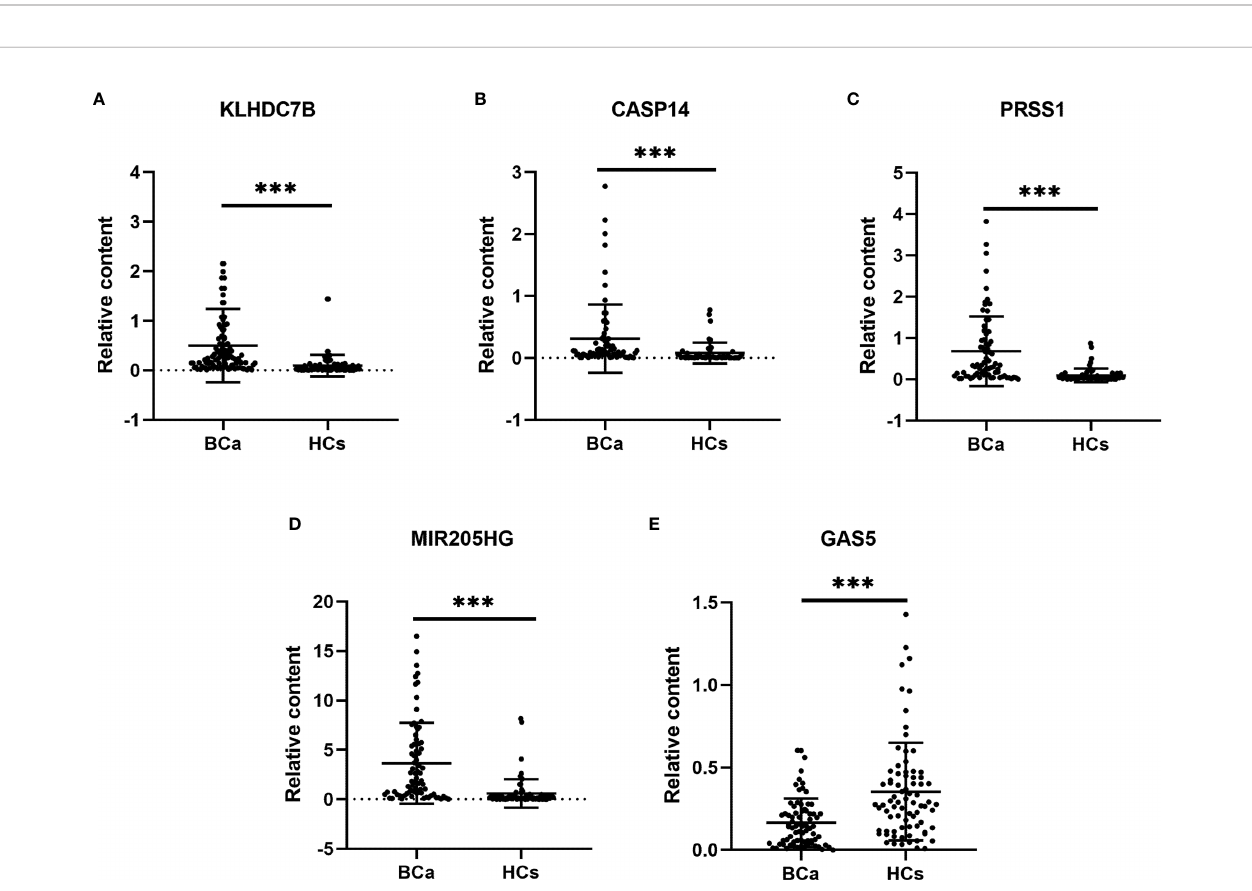
FIGURE 5 | Expression levels of urine exosomal mRNAs and lncRNAs in the validation cohort. (A – C) : Expression levels of mRNAs KLHDC7B (A) , CASP14 (B) , and PRSS1 (C) in BCa patients (n = 80) and HCs (n = 80) using RT-qPCR; (D, E) : Expression levels of lncRNAs MIR205HG (D) and GAS5 (E) using RT-qPCR. ***P <